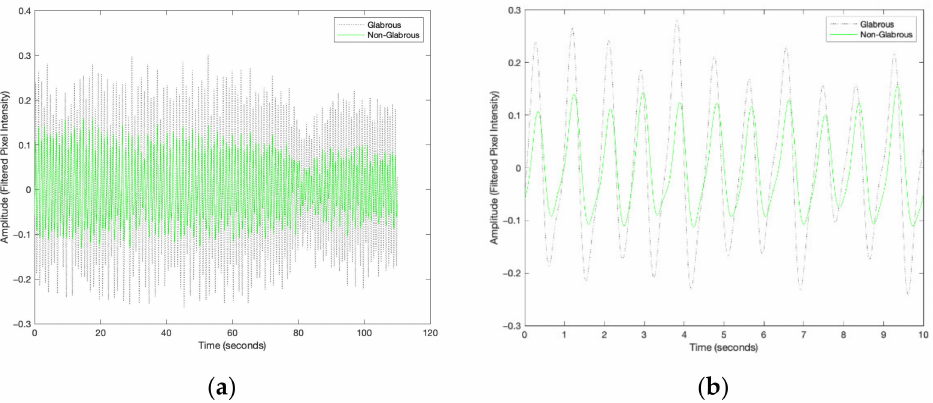
Figure 6. Example simultaneously acquired filtered glabrous (black) and non-glabrous (green) rPPG signals from the green channel, showing the entire duration of the acquisition ( a ) and the first 10 s ( b